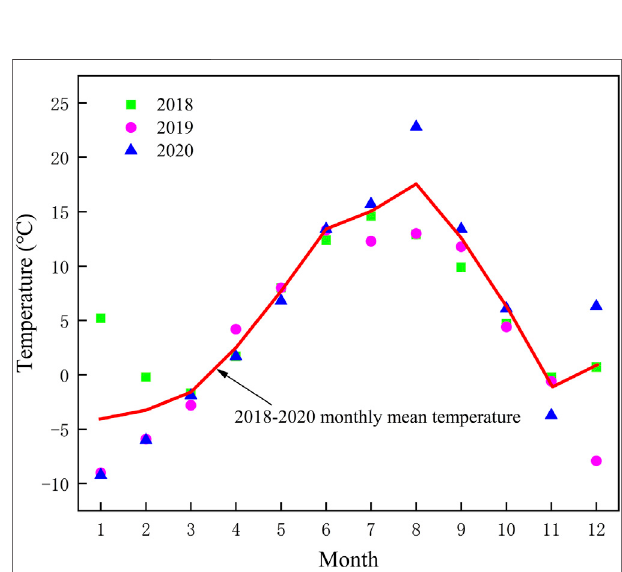
FIGURE 4 | The monthly temperature change of Zabuye Salt Lake from 2018 to 2020.